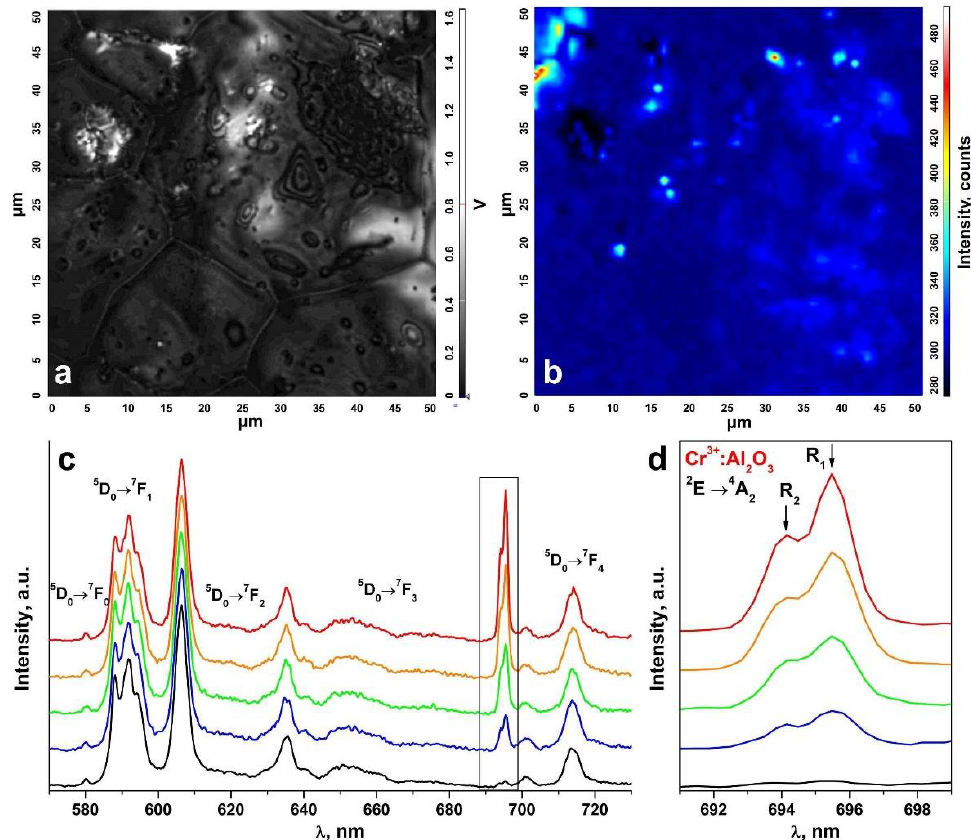
Figure 9. ( a ) Surface image of a ceramic specimen synthesized using slip casting; ( b ) R 1 and R 2 luminescence band intensity distribution map for the Cr 3+ ions in Al 2 O 3 on the surface area shown in Figure 9a; ( c ) luminescence spectra of the ceramic specimen excited with a λ = 473 nm laser (T = 300 K) corresponding to the intensity scale in Figure 9b; ( d ) R 1 and R 2 luminescence bands of the Cr 3+ ions in Al 2 O 3 for the 2 E → 4 A 2 transition.